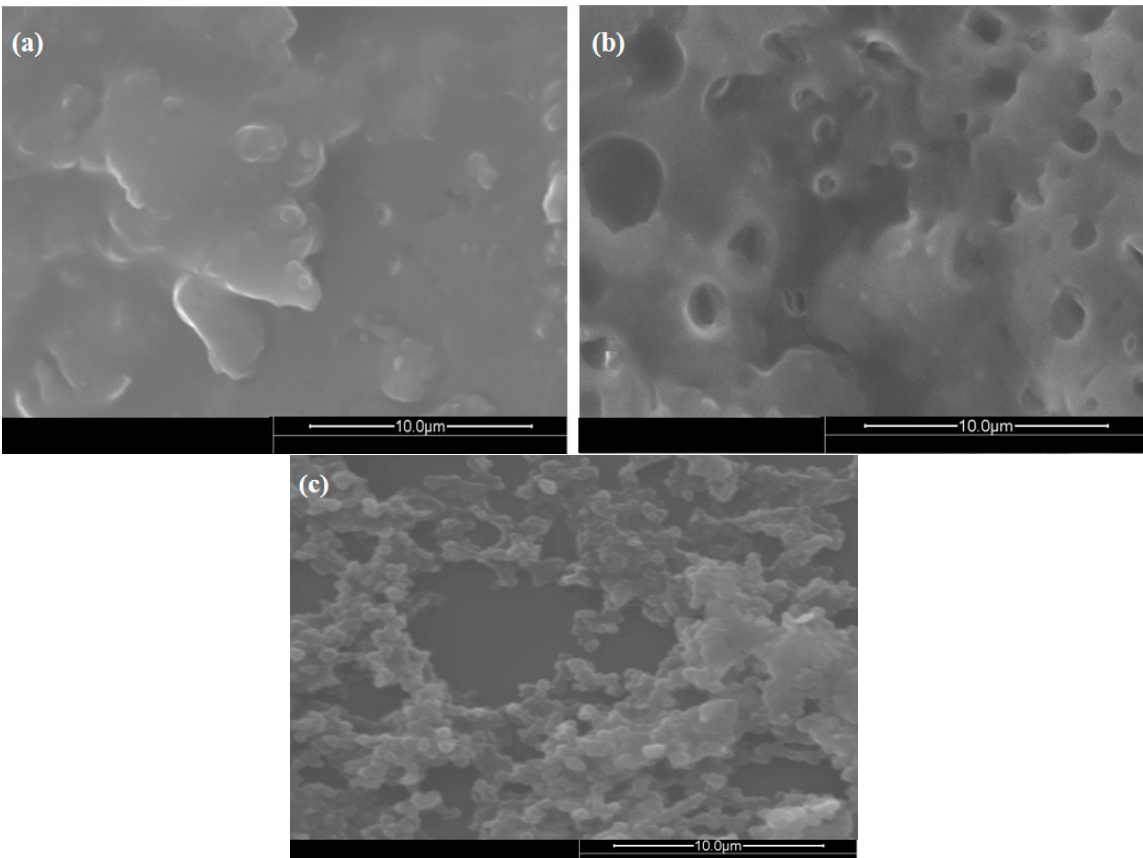
Figure 2. SEM images of polymer thin films coated onto transducer: ( a ) NIP, ( b ) MIP, ( c ) GO-MIP. The ATR-FTIR spectra of the GO-composite, MIP, and NIP are presented in Figure 3 to understand the chemical compositions of the samples. The polyurethane system’s IR spectra are measured between 500 and 4000 cm − 1 . For DPDI, the C-H stretching vibration displays a peak at 2963 cm − 1 , the peaks at 1631, 1375, and 1200 cm − 1 are allocated to the C=C, O-H, and C-O groups, respectively, and the peak at 1689 cm − 1 is associated to the C=O group. For numerous groups, including the C-H group, the NIP, MIP, and GO-MIP spectra have persisted at peaks 2958, 2957, and 2957 cm − 1 , respectively. C-O is allocated at peak 1143 cm − 1 and C=O associated to the peak 1716 cm − 1 for NIP, respectively, demon- strating the presence of an EGDMA cross-linker. The presence of carboxylic acid groups has been established by the O-H bending vibration at 1375 cm − 1 . Success in polymerizing the NIP, MIP, and GO-MIP is demonstrated by the reduced intensity of C=C at peak 1631 cm − 1 . The disappearance of this peak (1631 cm − 1 ) strongly suggests that the cross-linkers and monomers have formed a polymer [37]. Lower transmittance intensities of C=C stretching (1635 cm − 1 ) and double-bond C=O bending (553 cm − 1 ) are indicative of polymerization. While the absence of these peaks in NIP validates the removal of sugars, the typical peaks centered at 1035–1149 cm − 1 indicate the existence of polysaccharides in MIP and GO-MIP (composite). During NIP synthesis, sugar was not added during polymerization. However, for the preparation of MIP and GO-MIP, sugar was added, allowing the polymerization under the conditions mentioned in the Materials and Methods section. Sugar (sucrose) has been removed by treating both fabricated sensors with di-ionized water with continuous stirring. As the sugar is water-soluble, it leaves the cavities complementary in size, shape, and geometry in the polymeric matrix (MIP